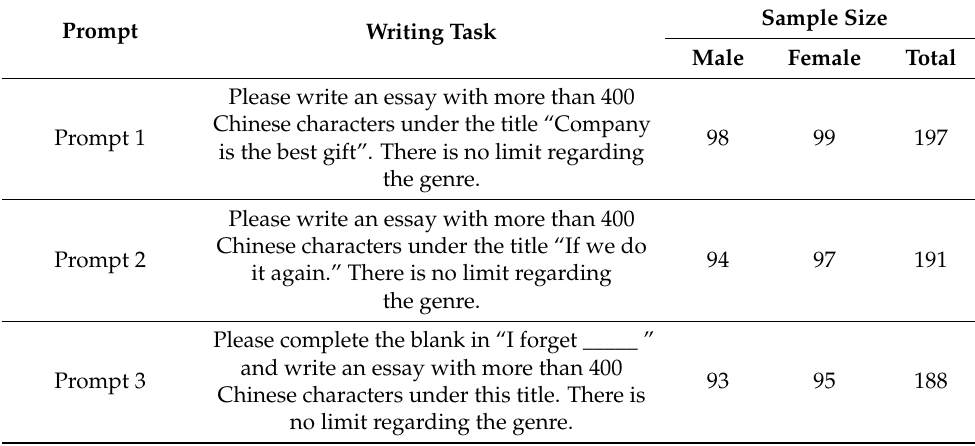
Table 1. Sample size of each